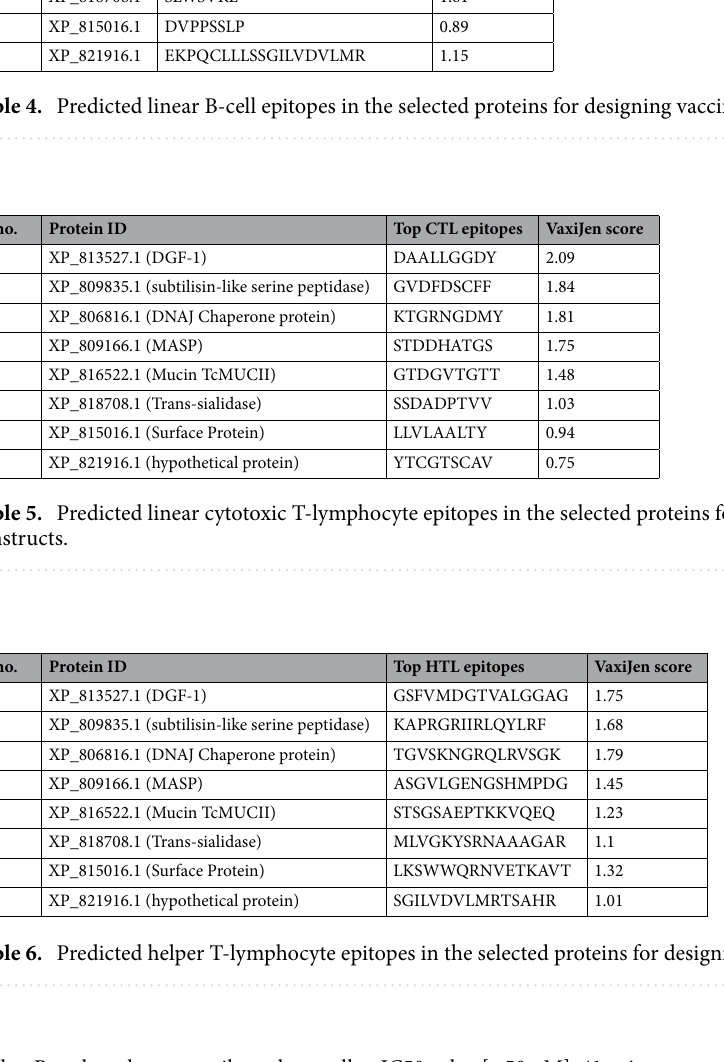
Table 6. Predicted helper T-lymphocyte epitopes in the selected proteins for designing vaccine constructs.